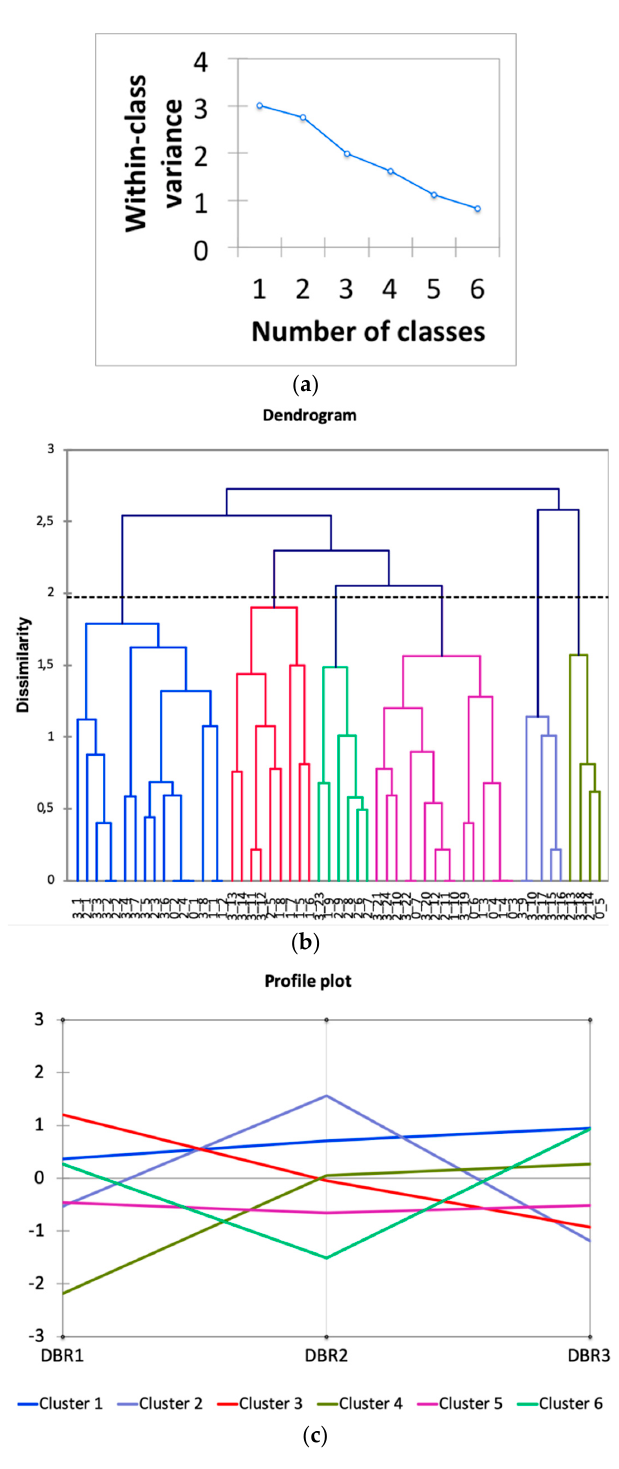
Figure 4. Agglomerative hierarchical clustering (AHC): Students’ views on the use of BIM and the three-dimensional (3D) tool during the second implementation phase. ( a ) Evolution of variance; ( b ) dendrogram and ( c ) profile plot.